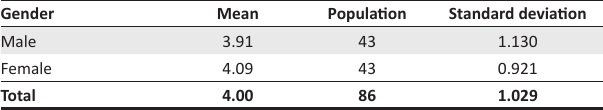
TABLE 4: Perceived threat by gender (mean scores).